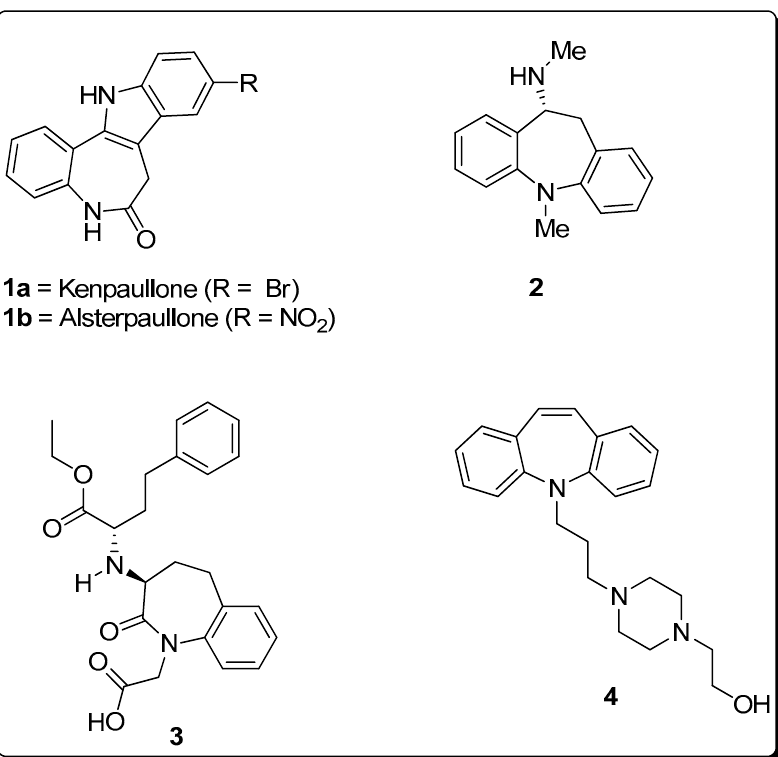
Figure 1. Structures of kenpaullone, alsterpaullone ( 1a,b ), metapramine 2 , benazepril 3 and opipramol 4 .